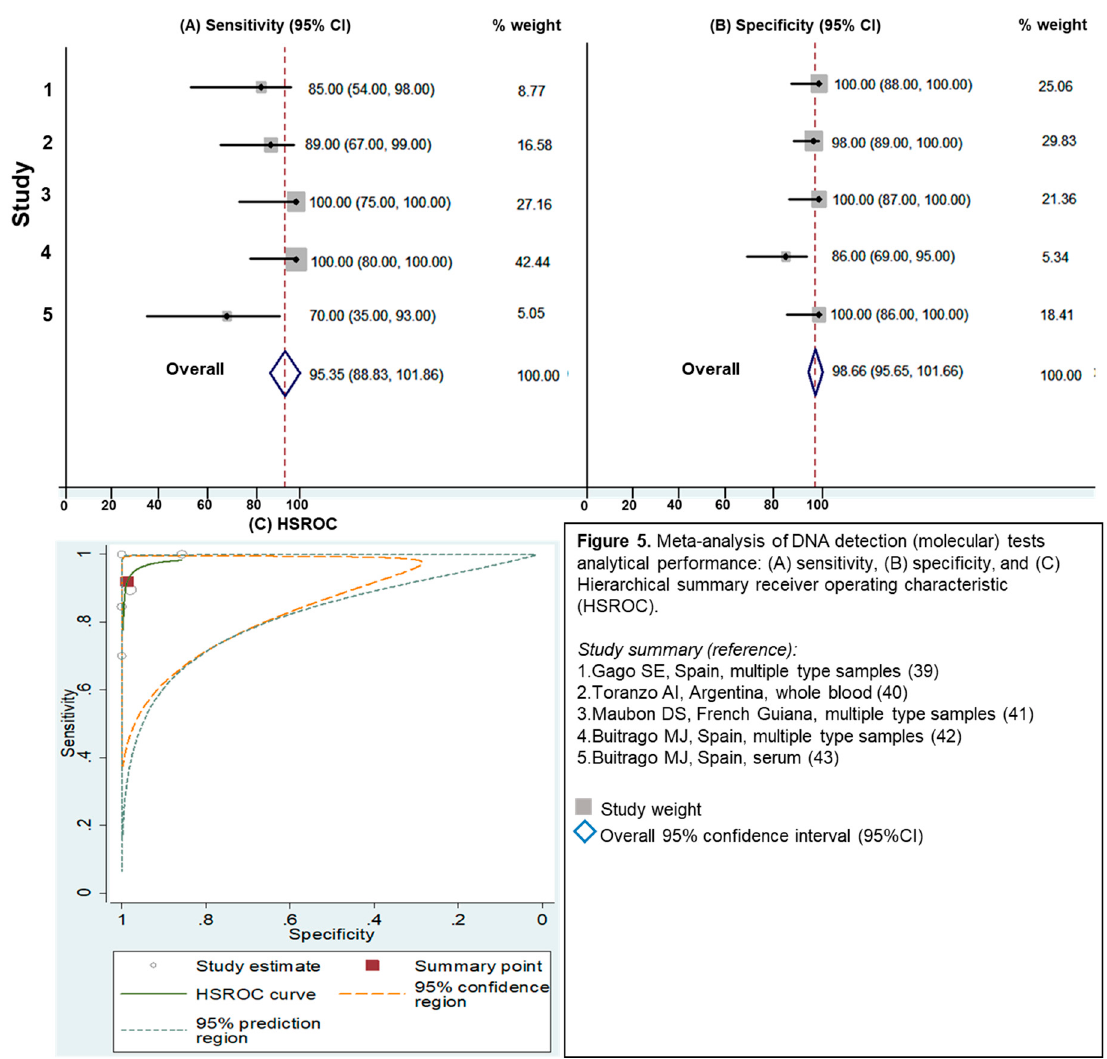
Figure 5. Meta-analysis of DNA detection (molecular) tests analytical performance: (A) sensitivity, (B) specificity, and (C) Hierarchical summary receiver operating characteristic (HSROC).